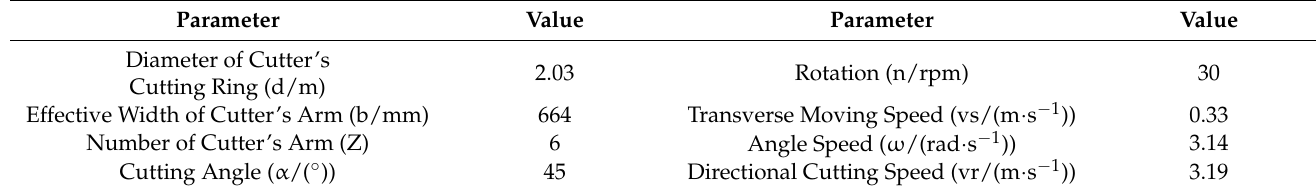
Table 4. The parameter of cutter and cutter